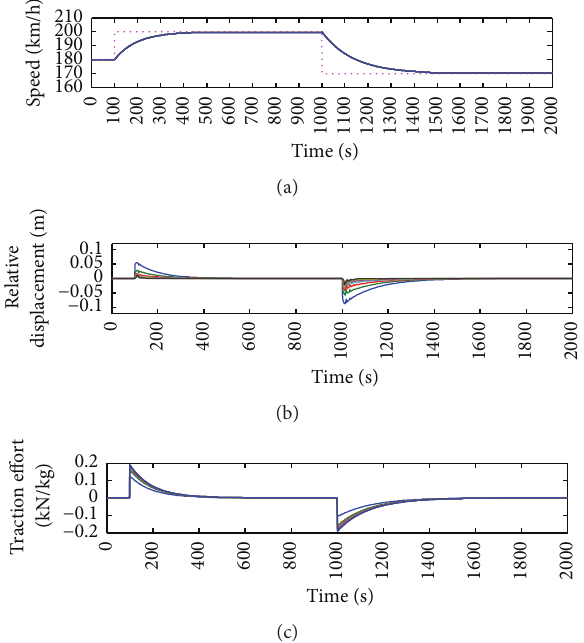
Figure 4: Optimal curves for each car under the fuzzy constrained predictive